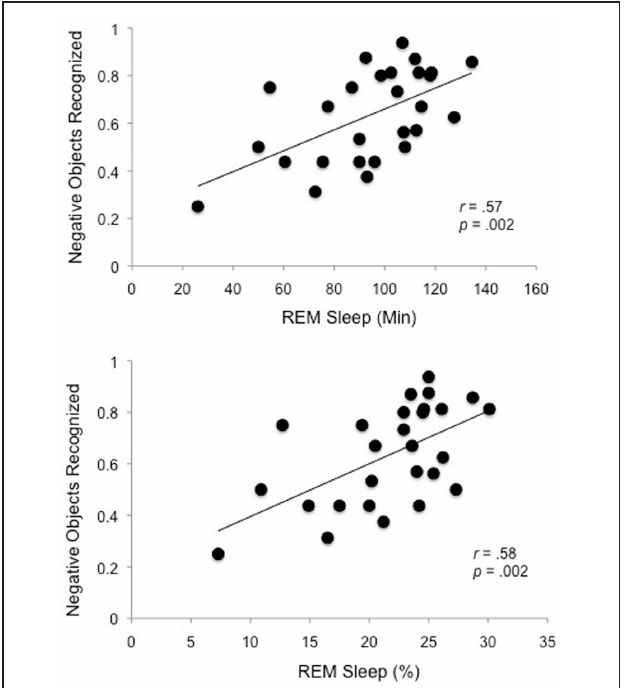
FIGURE 3 | REM sleep correlations. Specific recognition of negative objects is selectively positively correlated with time spent in REM sleep (REM Sleep Min) and with percent of the night spent in REM sleep (REM Sleep %).